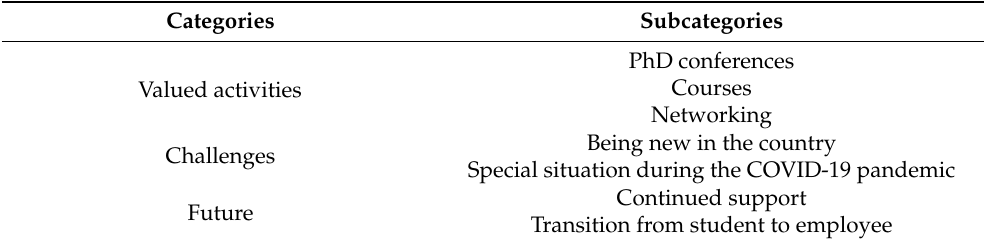
Table 3. PhD alumni’s views on aspects of membership of the Norwegian Research School of Global